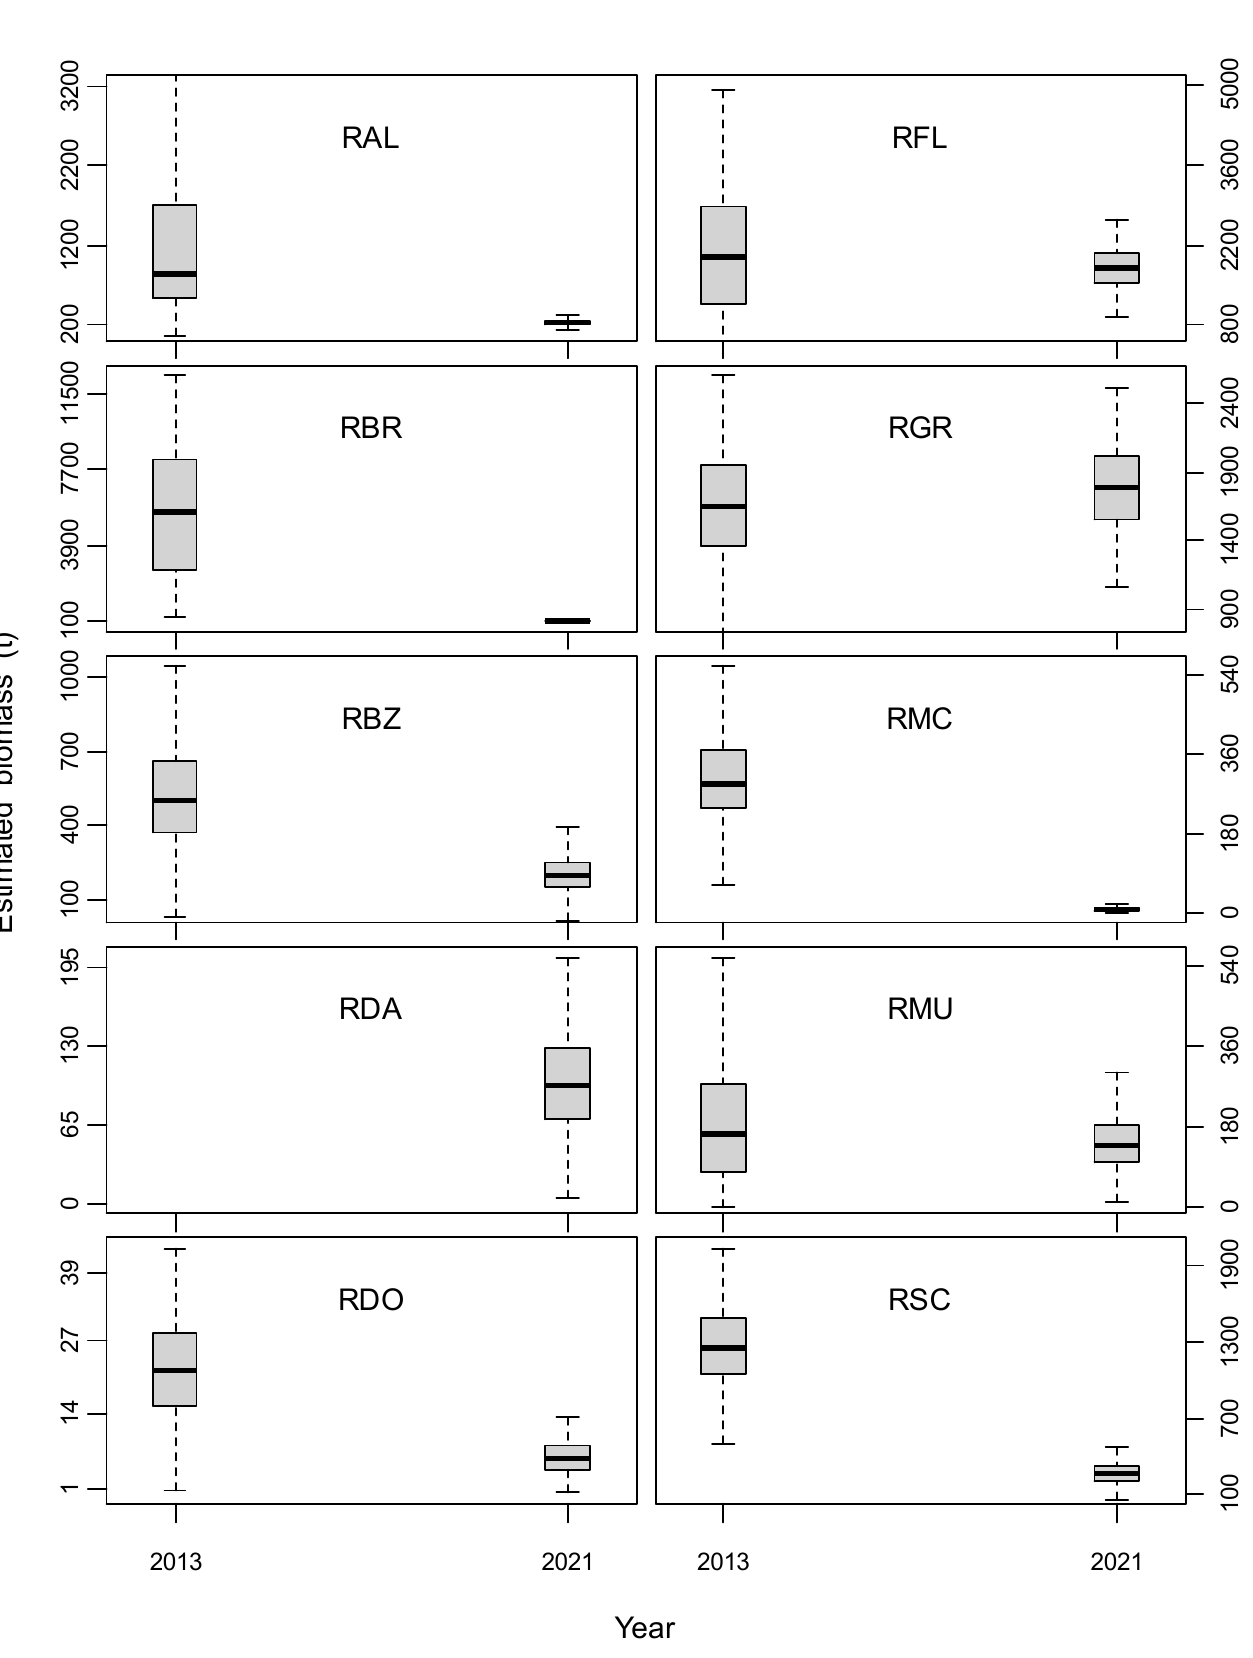
Figure 4. Biomass estimates of skate species in the South Skate box, from the two surveys in 2013 and 2021. Box plots: first, second, and third quartiles, whiskers to approximate 95% confidence intervals from randomized resampling in either year. Falkland Islands species codes correspond to Table